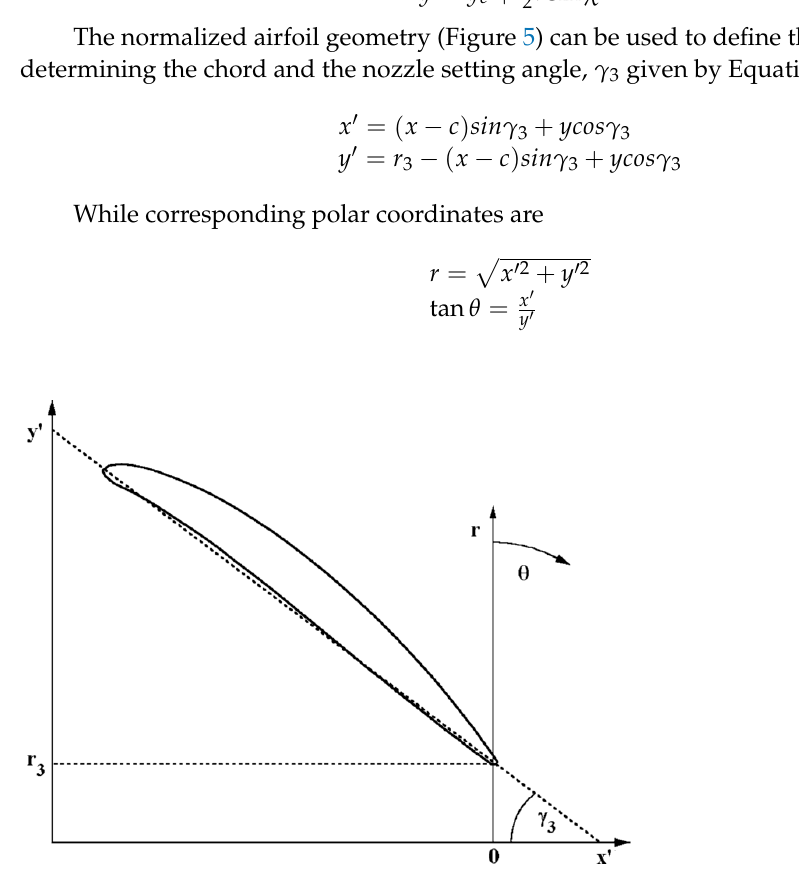
Figure 5. Transformation of the profile to be used for NGV.